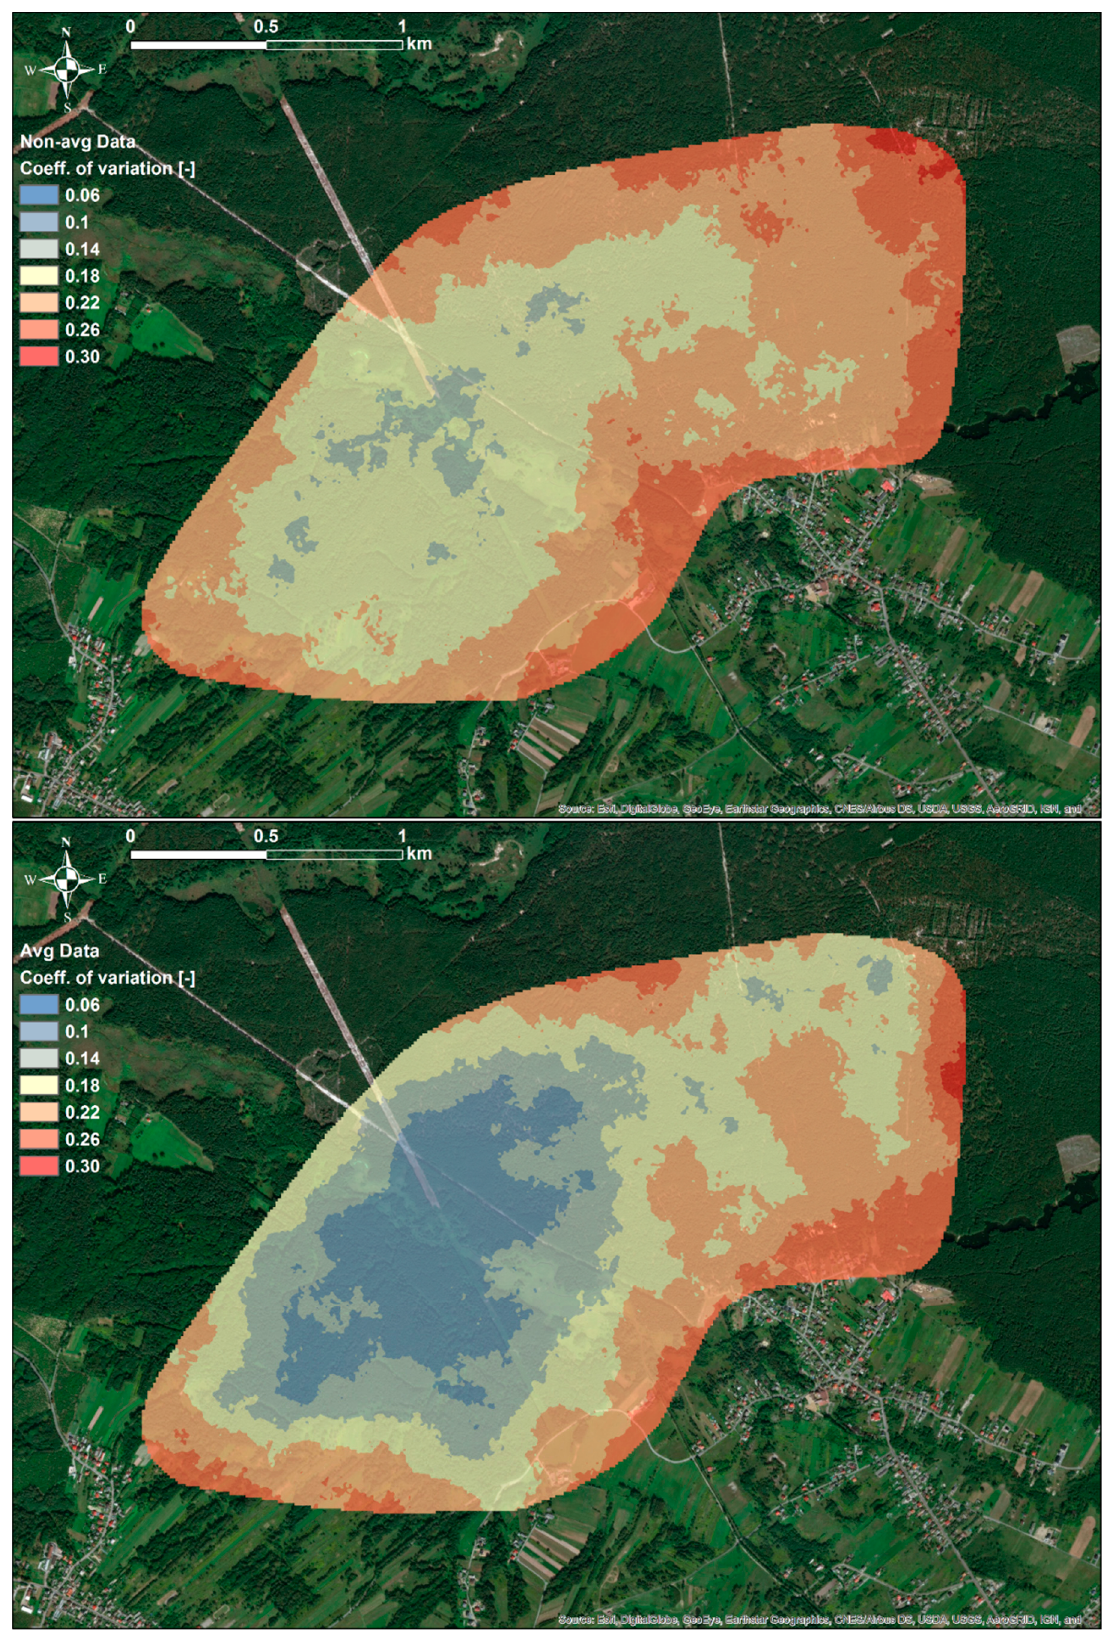
Figure 4. Spatial distributions of the coefficient of variation calculated as κ sim-std divided by κ sim-avg , simulated using κ non-avg (upper figure) and κ avg (bottom figure) data sets.